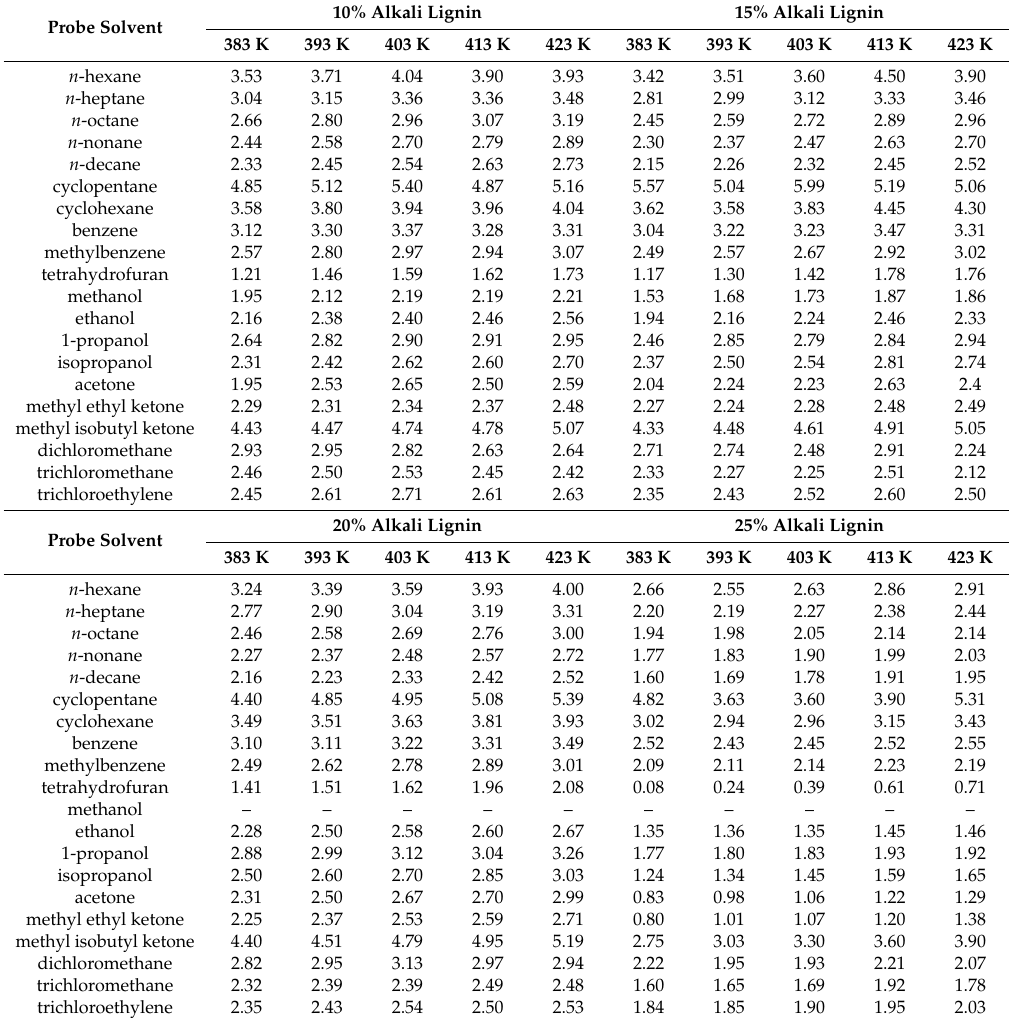
) of the probe solvents at different temperatures. 12